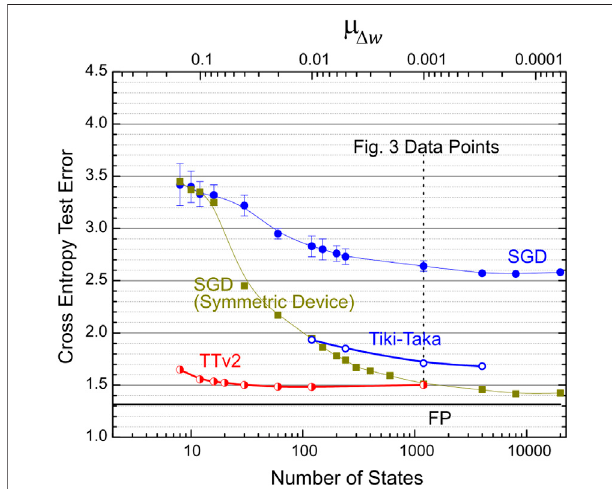
FIGURE 4 | LSTM training simulations for SGD, Tiki-Taka, and TTv2 algorithms as a function of μ Δ w . 10x increase in μ Δ w results in a simultaneous 10x reduction in the number of states and a 10x increase in the cycle-to-cycle update noise. Circles correspond to an array model with non-symmetric devices, whereas squares are for symmetric and linear devices. All symbols report the test error at the end of the 50th epoch, and the error bars capture the test error fl uctuations for the last fi ve epochs. Lines are guides to the eye. The fl oating-point baseline is shown with the black horizontal line at 1.32 test error. After random weight initialization, an untrained network gives ∼ 4.46 test error corresponding to a random